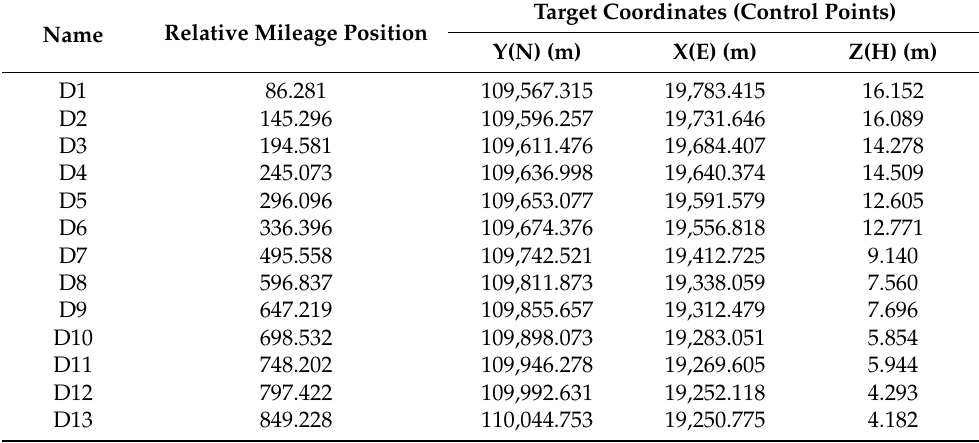
Table 5. Target coordinates measured by total station.